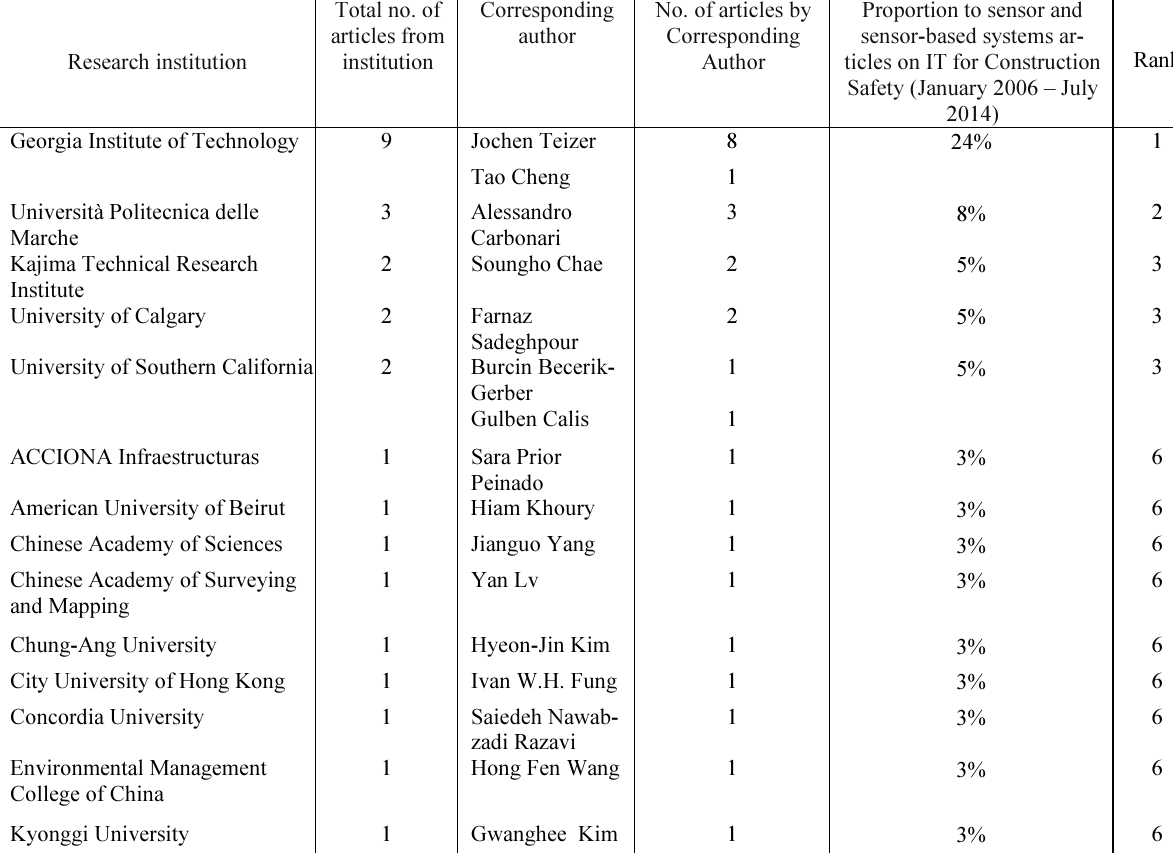
Table 5. Corresponding authors of papers on sensors and sensor-based systems for construction safety management